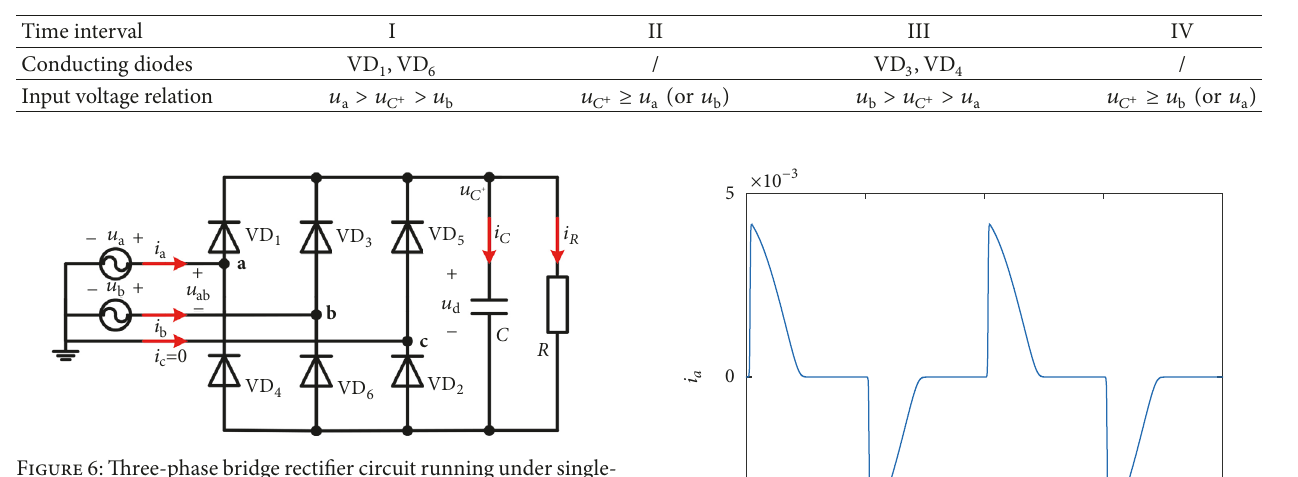
Table 3: Conduction situations of six diodes.